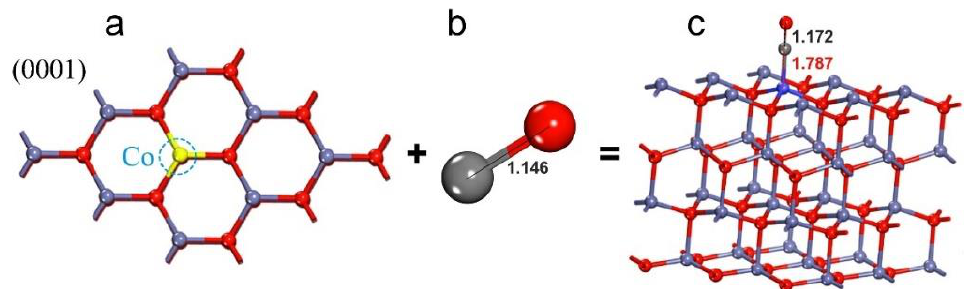
Figure 8. CO adsorption on the Co-doped ZnO (0001) surface. ( a ) Co-doped ZnO (0001) surface. ( b ) CO molecule, ( c ) CO adsorption on the Co-doped ZnO (0001) surface. Note that distances are in Å. Modified from reference [100].